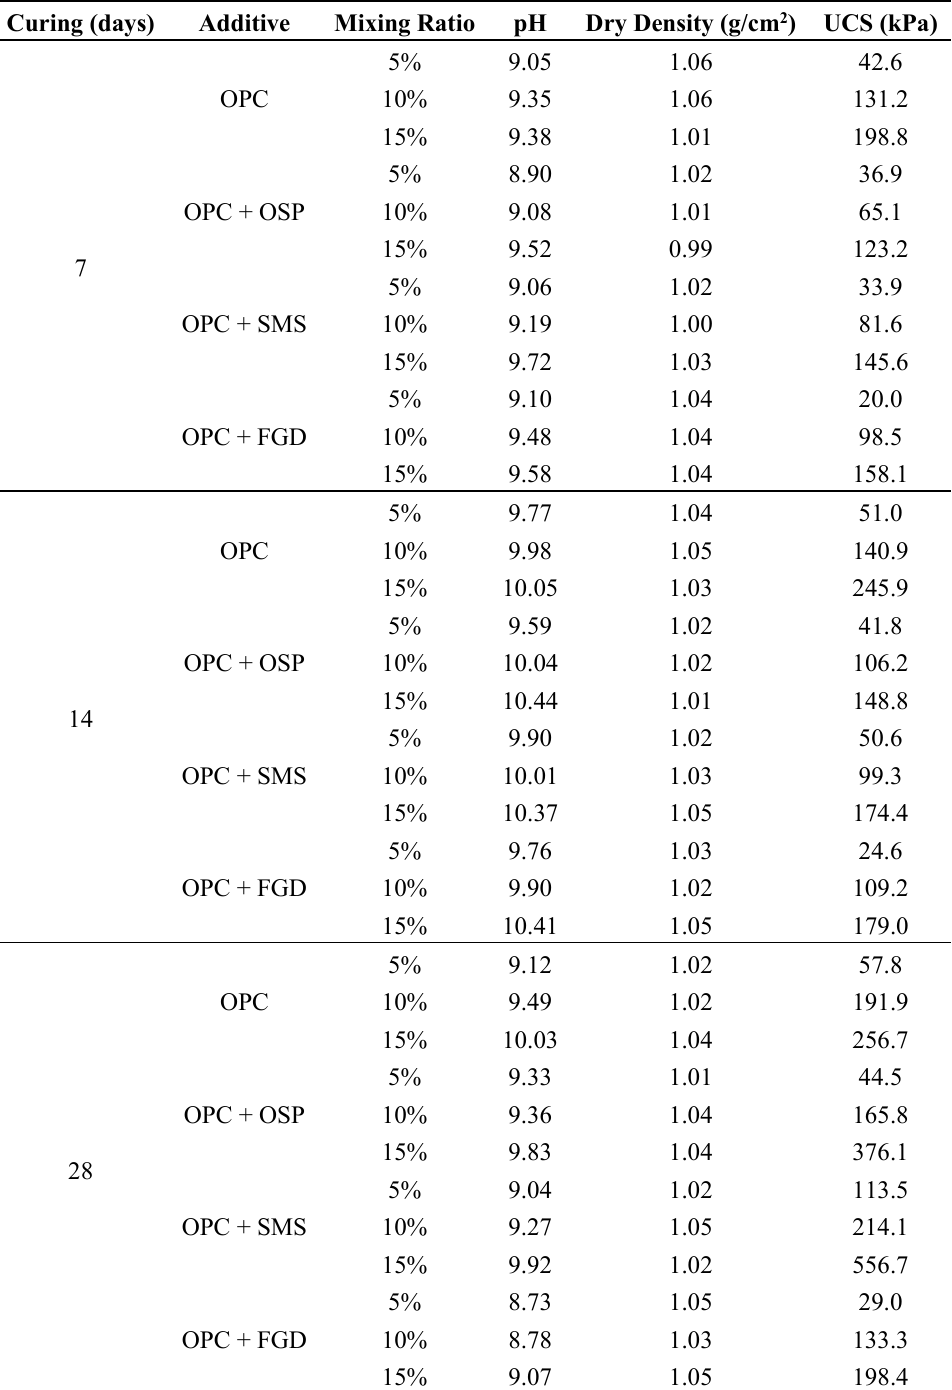
Table 4. Results of experiment with the curing period of test specimens. UCS: unconfined compressive